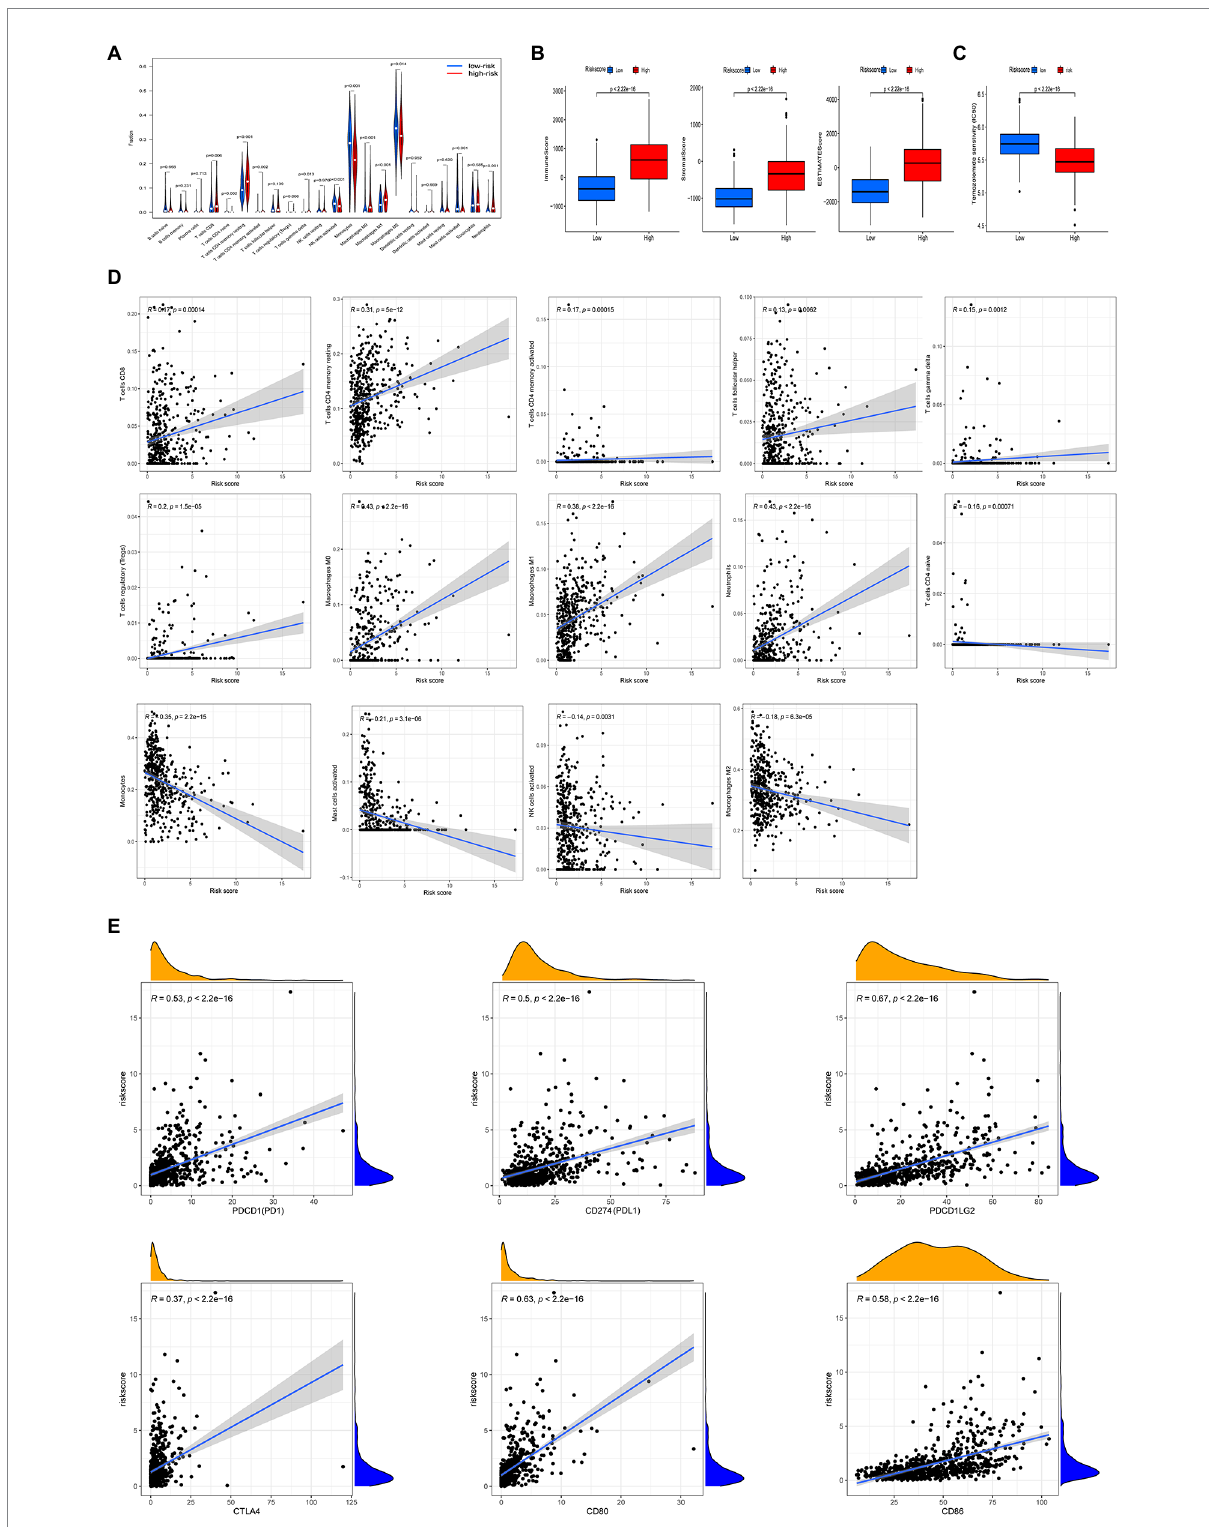
FIGURE 7 Different tumor microenvironment (TME) characteristics and response to temozolomide therapy between the two risk groups in TCGA cohort. (A) Abundance of tumor-infiltrating immune cells (TIICs) between high and low risk groups. (B) Comparisons of immune score, stromal score, and ESTIMATE score between high and low risk groups. (C) Half maximum inhibitory concentrations (IC50) for temozolomide between the two risk groups using data from the GDSC database. (D) Correlation between risk score and immune cell type abundance. (E) Correlation between risk score and immune checkpoint blockers ( PDCD1 , CD274 , PDCDLG2 , CTLA4 , CD80 , and CD86